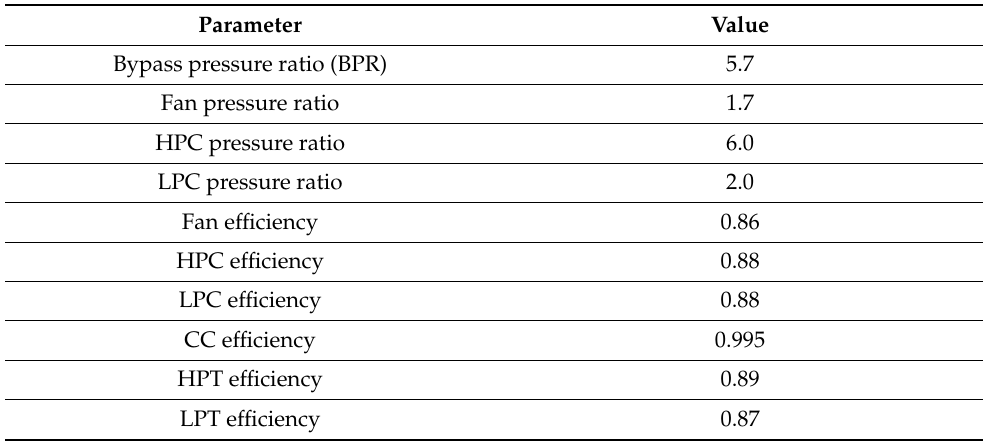
Table 3. Engine characteristics adapted from Gaspar and Sousa